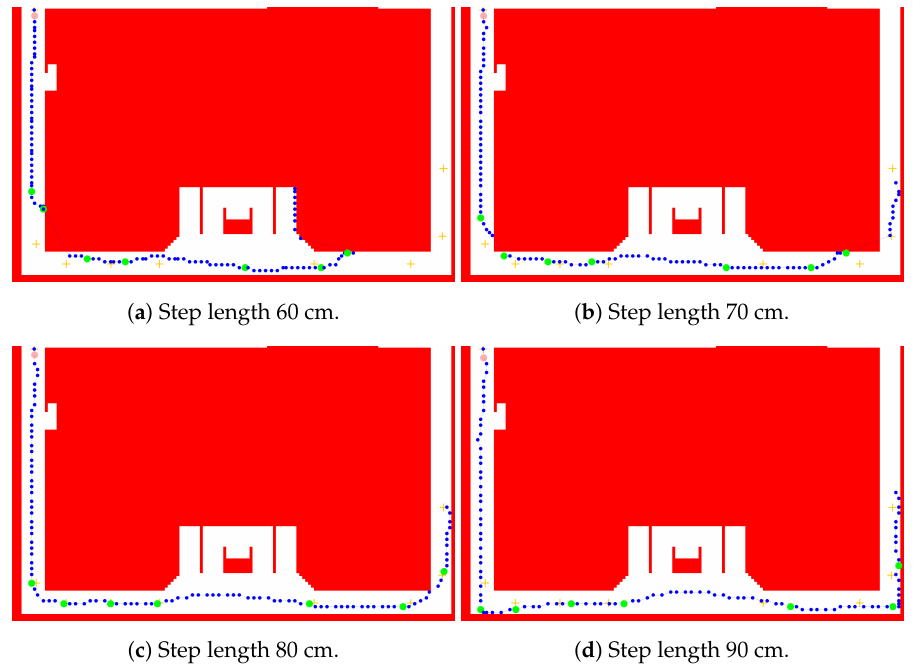
Figure 6. Trajectories of the detected positions using the same sensor measurements, methods, and configurations with different step length estimations. The subfigures display the underestimated step length values ( a , b ), the best achieved result ( c ), and the step length overestimation ( d